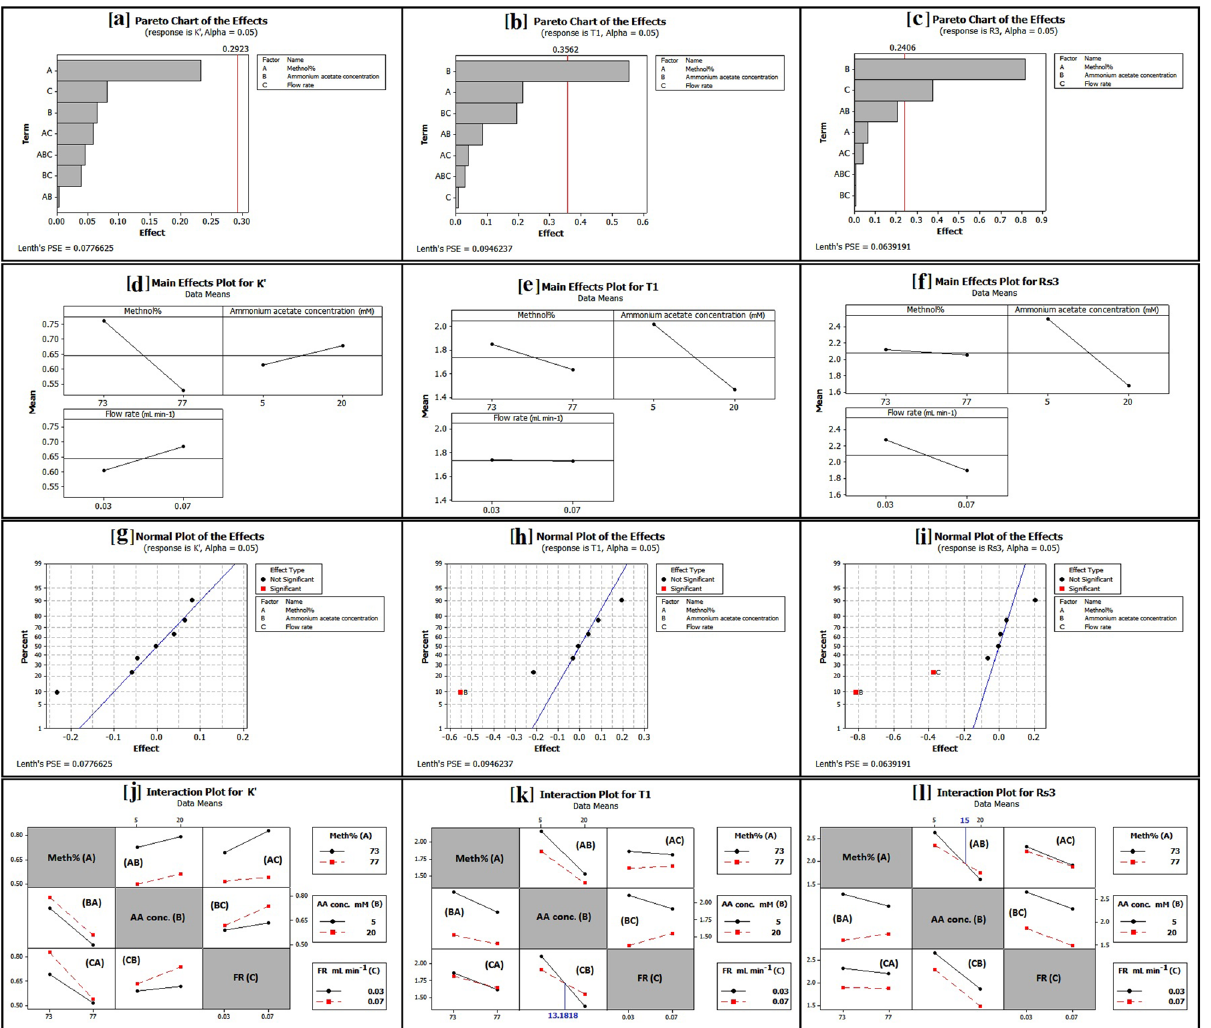
Figure 1. 2 3 FFD pareto charts ( a – c ) and normal plots ( g – i ) of the effects on the chromatographic responses at alpha = 0.05, and main effect plots ( d – f ) and interaction plots ( j – l ) for chromatographic responses by data means type